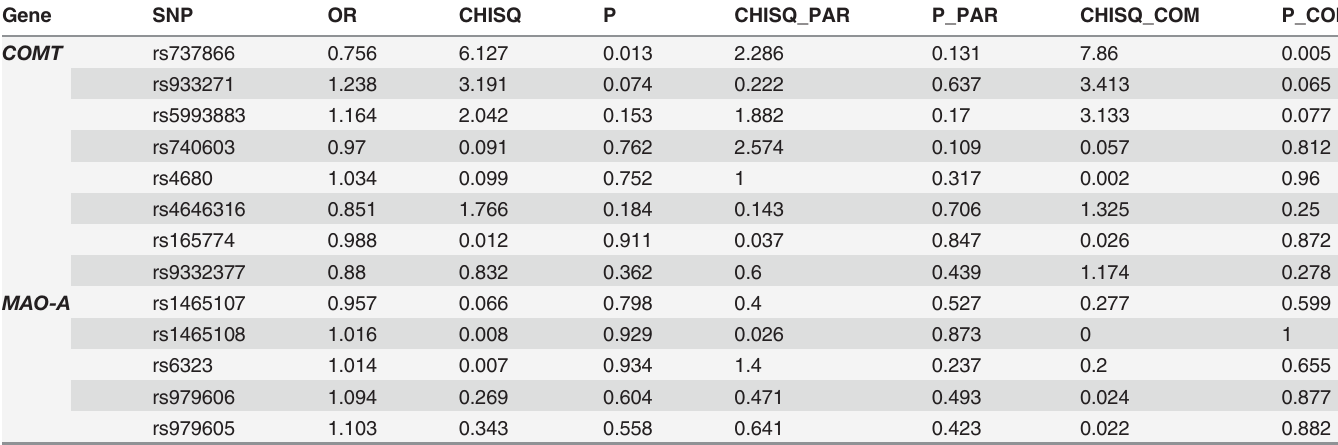
Table 1. Single-marker analysis of OCD association with catechol- O -methyltransferase and monoamine oxidase A single-nucleotide polymorphisms.